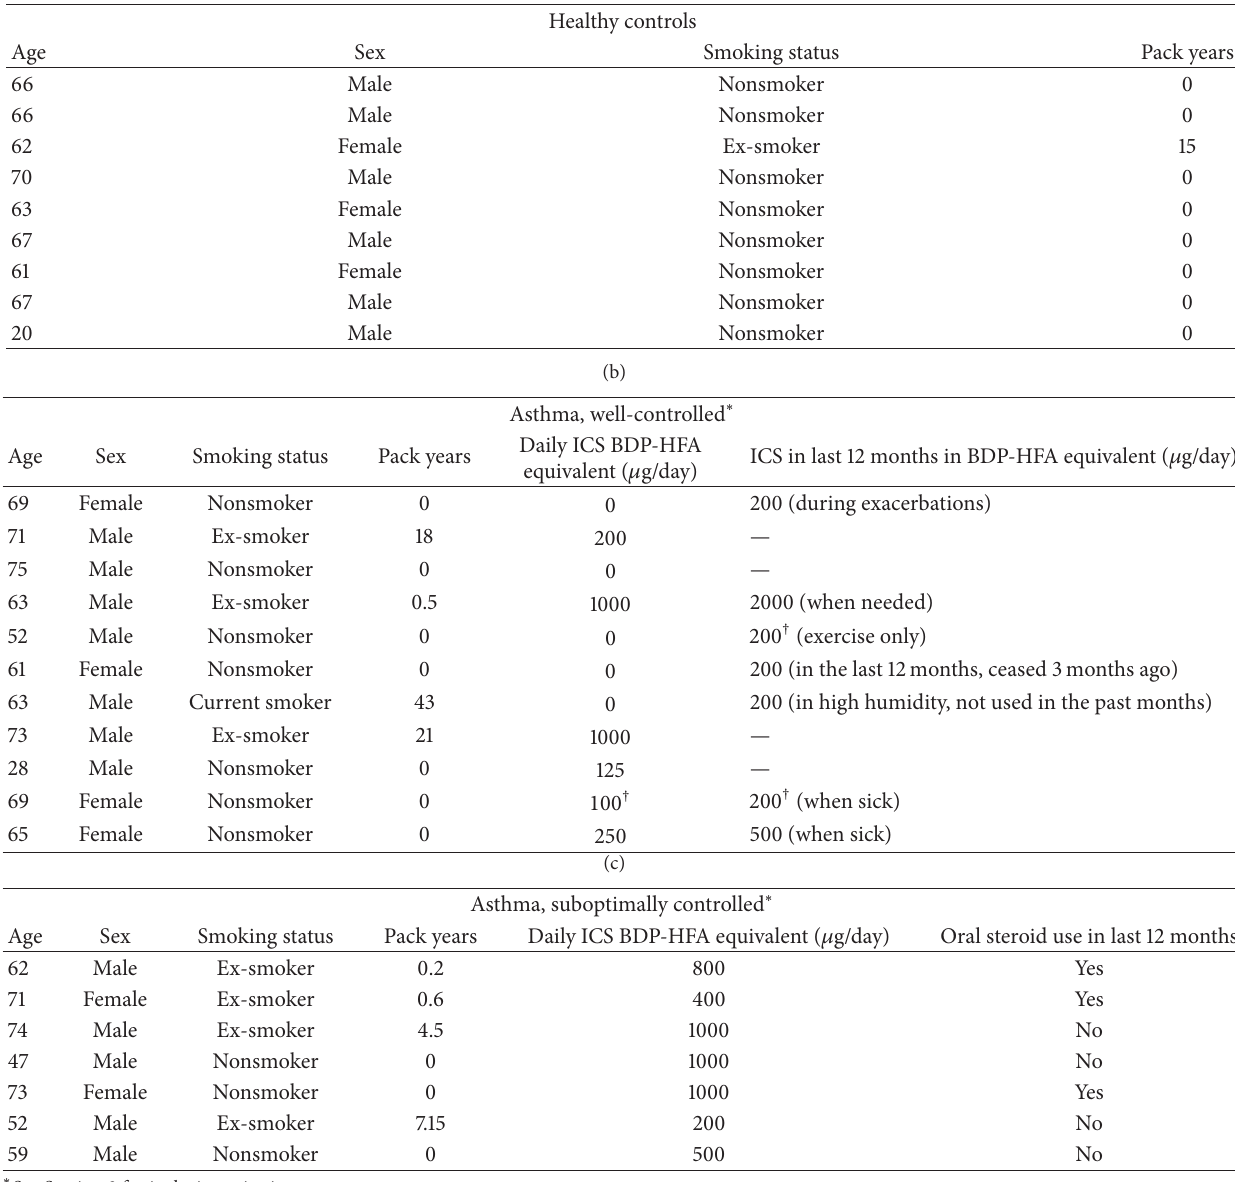
Table 2: Smoking history and inhaled corticosteroid (ICS) use of healthy controls and asthmatics.